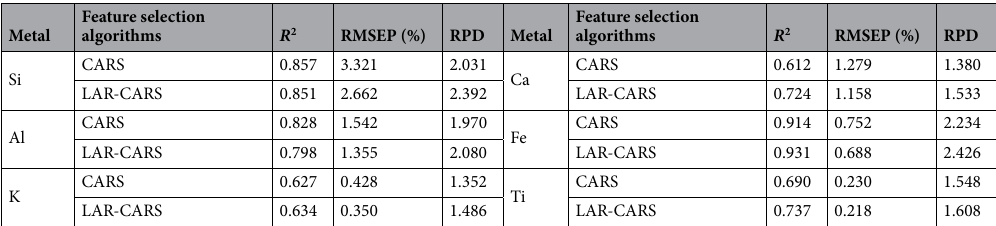
Table 3. Statistical parameters of core modeling for independent